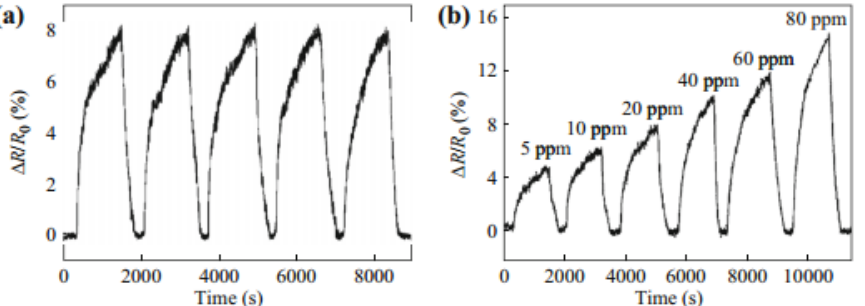
Figure 8. ( a ) Reproducibility of CRG sensors to 20 ppm DMMP vapor. ( b ) The response curve of the CRG sensor to dimethyl methylphosphonate (DMMP) vapor under a 5–80 ppm concentration range, “Reprinted/adapted with permission from Ref. [91]. 2012, Hu, N. et